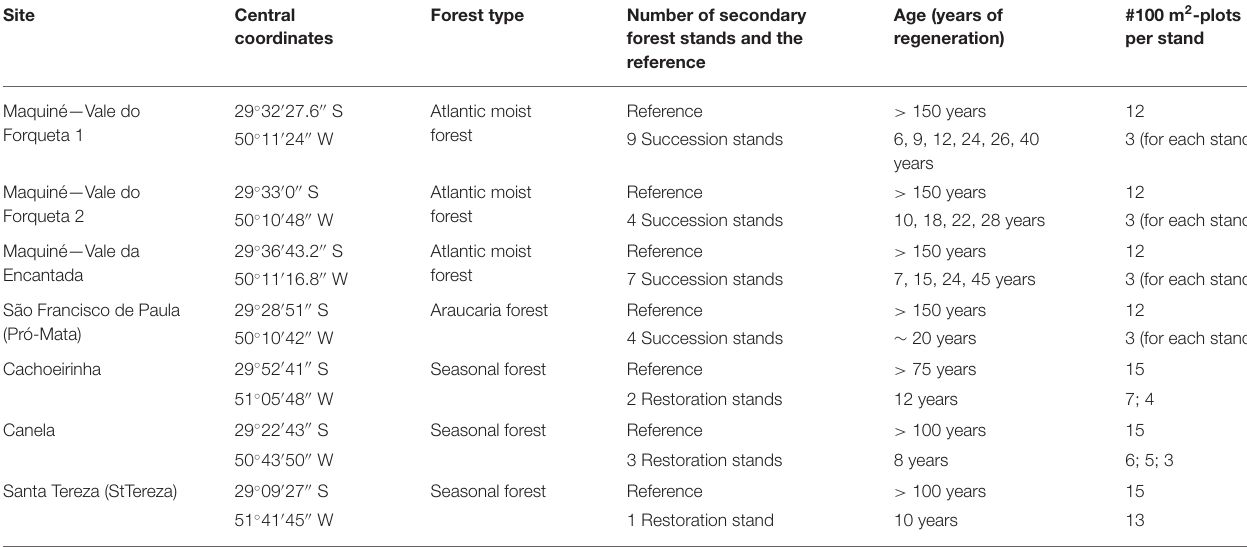
TABLE 1 | General information for each study site in terms of site name, forest type, number of secondary forest stands evaluated, and stand age.